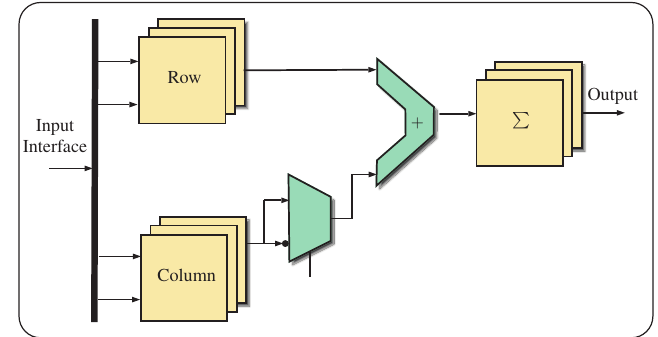
Figure 9. Matrix adder